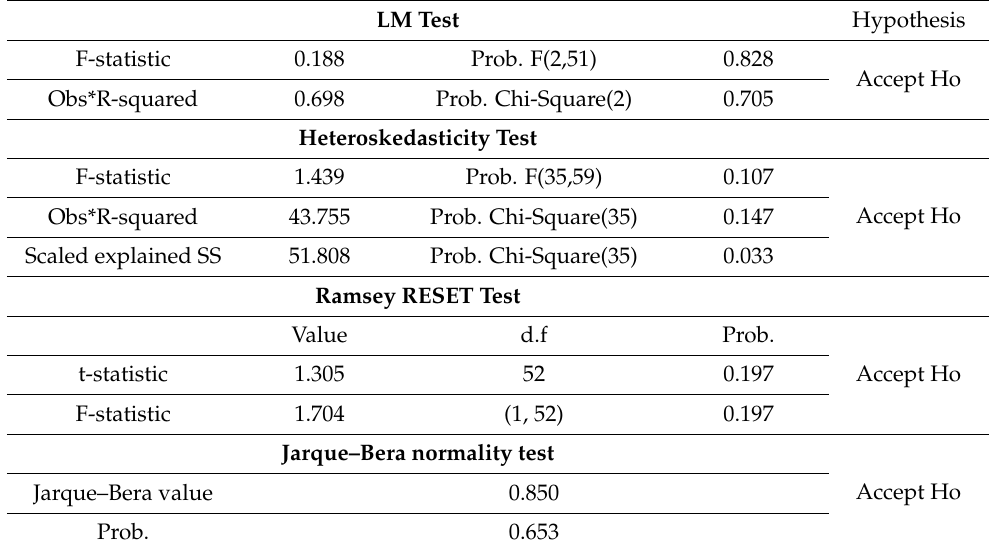
Table 8. Diagnostic Test